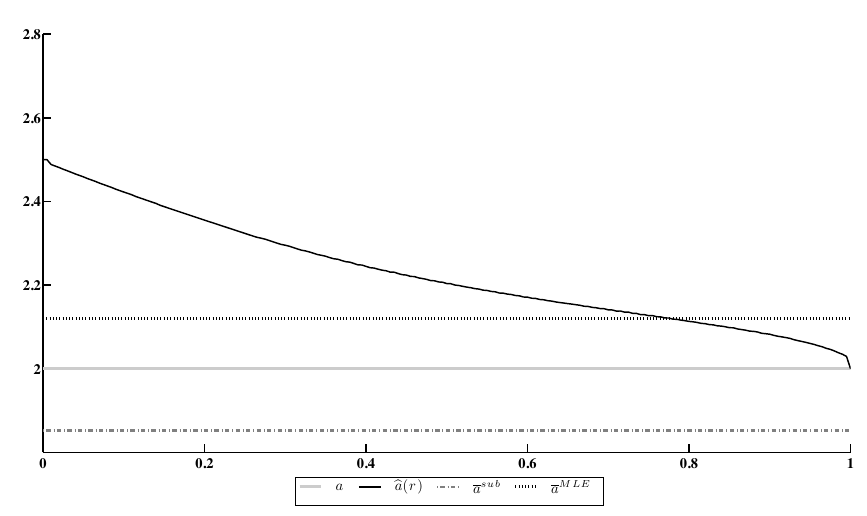
Figure 5. Estimation of the coefficient a under conformity constraint based on the